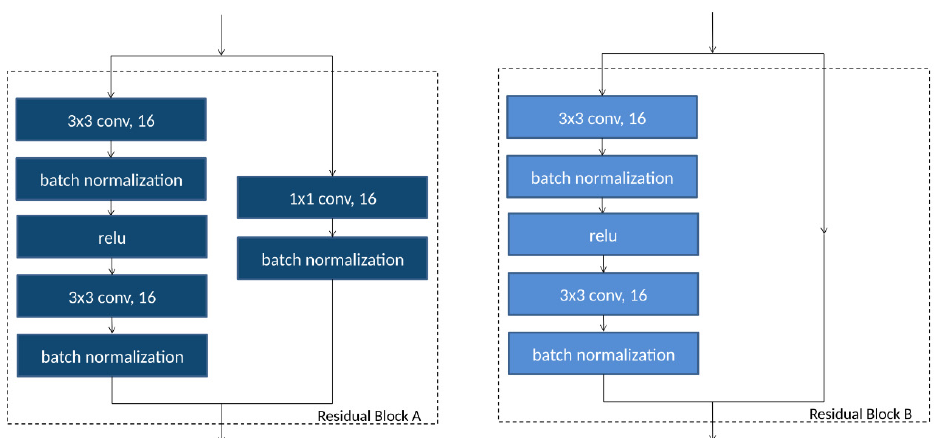
Figure 1. Proposed residual neural network architecture for classification of 201 × 201 px image patches. All convolution layers are followed by batch normalization layers and ReLU activations. Max pooling layers implement 2 × 2 maximum pooling with stride two. The final dense layer contains class scores for the six classes.